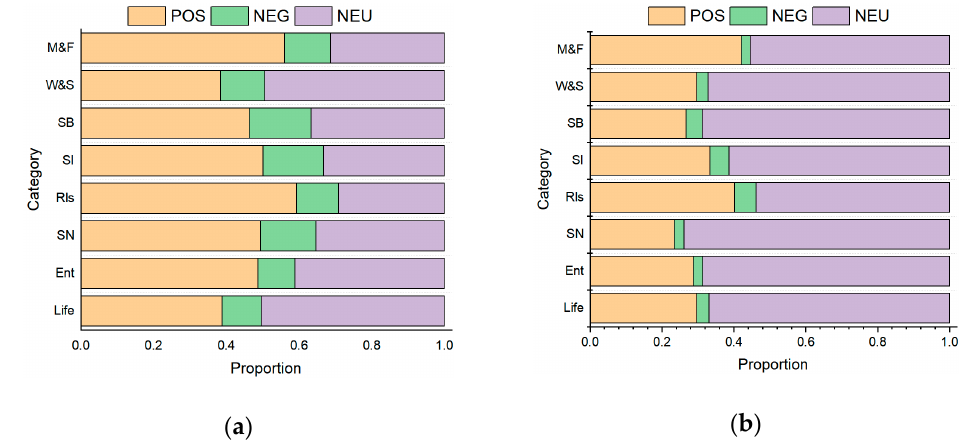
Figure 4. Sentiment distribution of ( a ) Chinese and ( b ) English topic data.